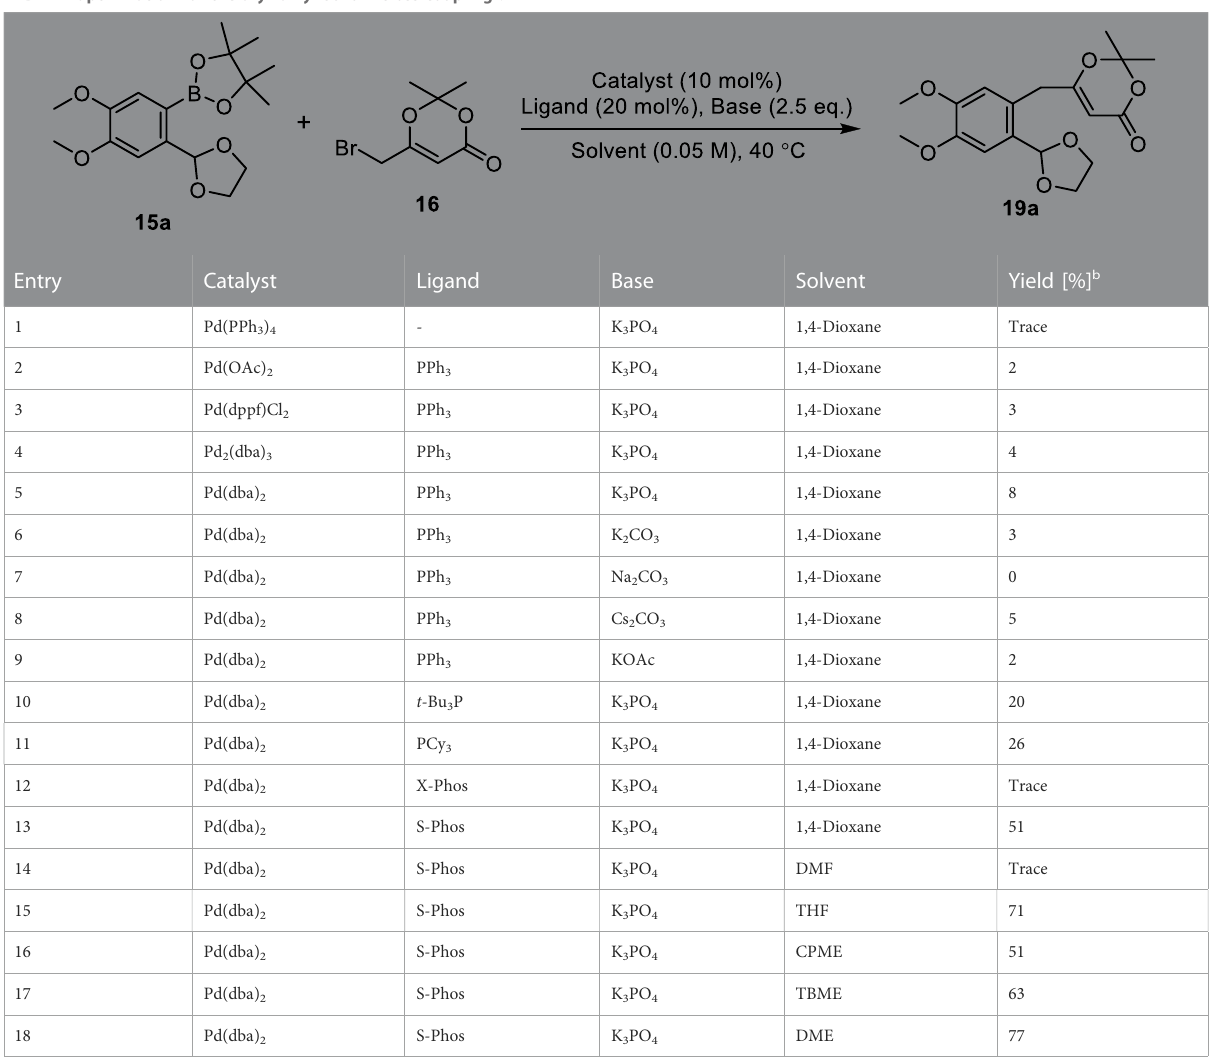
TABLE 1 Optimization for the aryl – alkyl Suzuki cross-coupling a